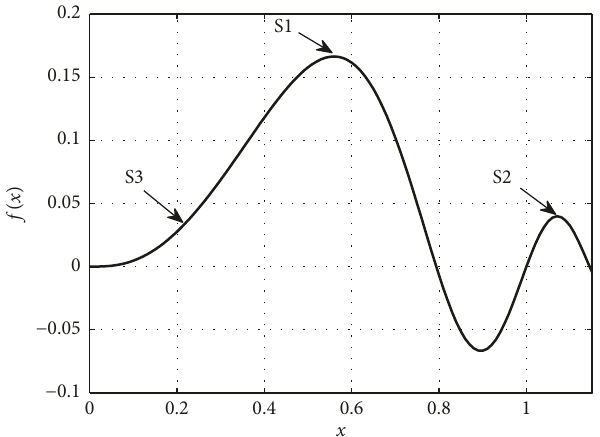
Figure 2: Plausible optima in a 1D objective